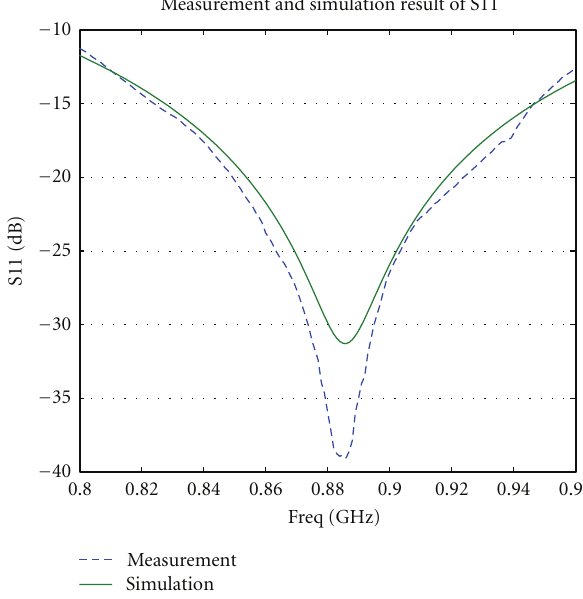
Figure 3: S11 of the actual antenna and simulation model.